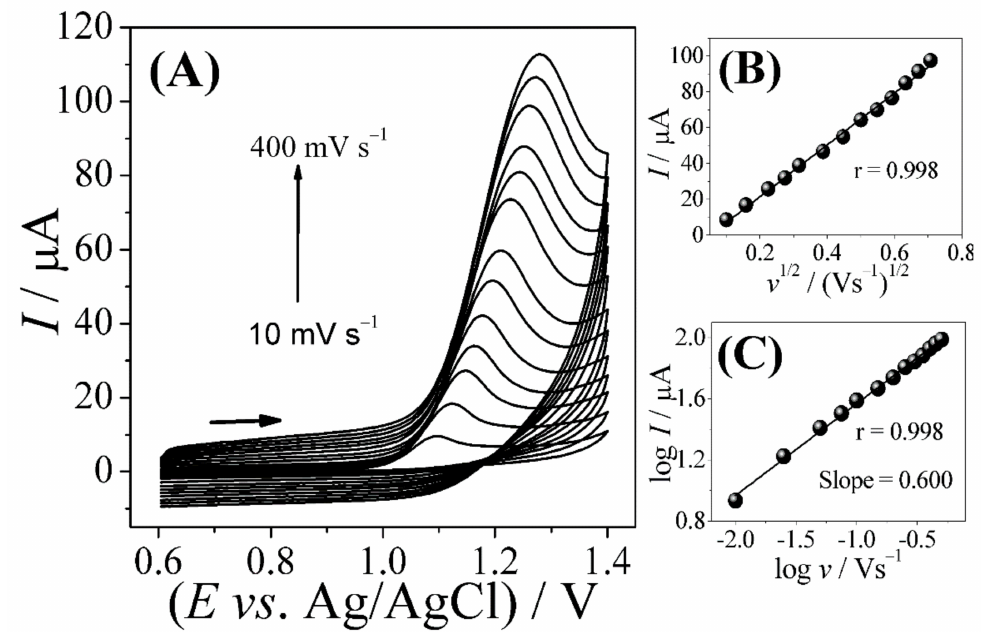
Figure 5. ( A ) Cyclic voltammograms at different scan rates (10–400 mV s − 1 ) based on the application of the Bi-rGO-CTS/GCE sensor in 0.20 mol L − 1 phosphate-buffered solution (pH 6.0) in the presence of 50.0 µ mol L − 1 concentration of 3-methylmorphine. Plots: ( B ) I pa vs. ν 1/2 and ( C ) log I pa vs. log ν